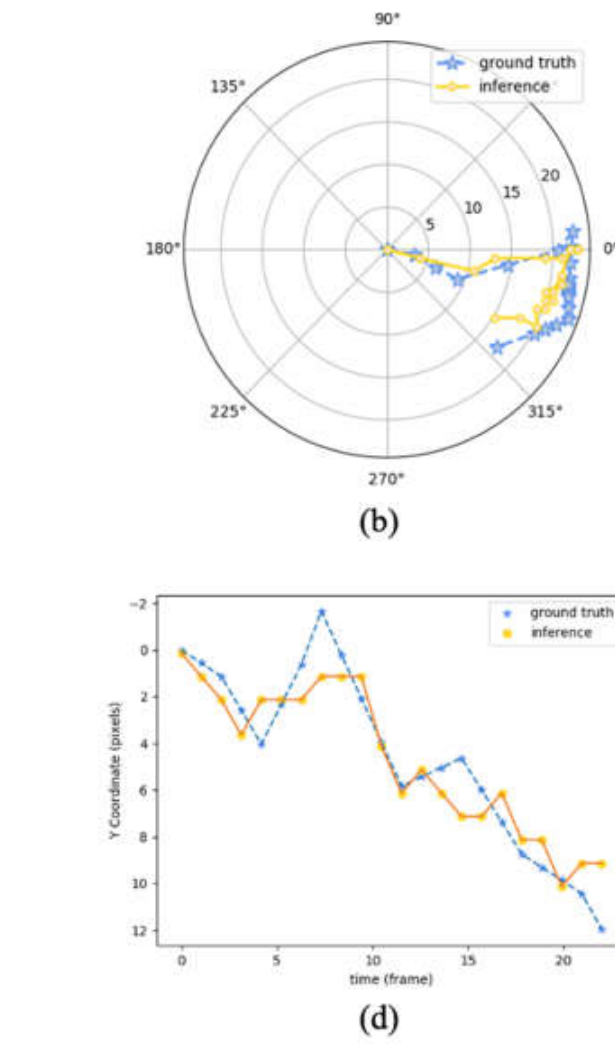
Figure 5. Hyoid center trace plots between the timestamps of hyoid onset (the frame when the hyoid starts to move) to offset (at the moment when the hyoid starts to move away from its maximum position of superior-anterior movement) in 2D Cartesian axis ( a ), polar axis ( b ), x -axis ( c ), and y -axis ( d ). From an example test sequence of 10 mL thin liquid swallow, female subject, from hyoid onset to offset. The blue line represents the ground truth of the hyoid path, and the yellow one represents the inference path. Length unit at the polar axis is in